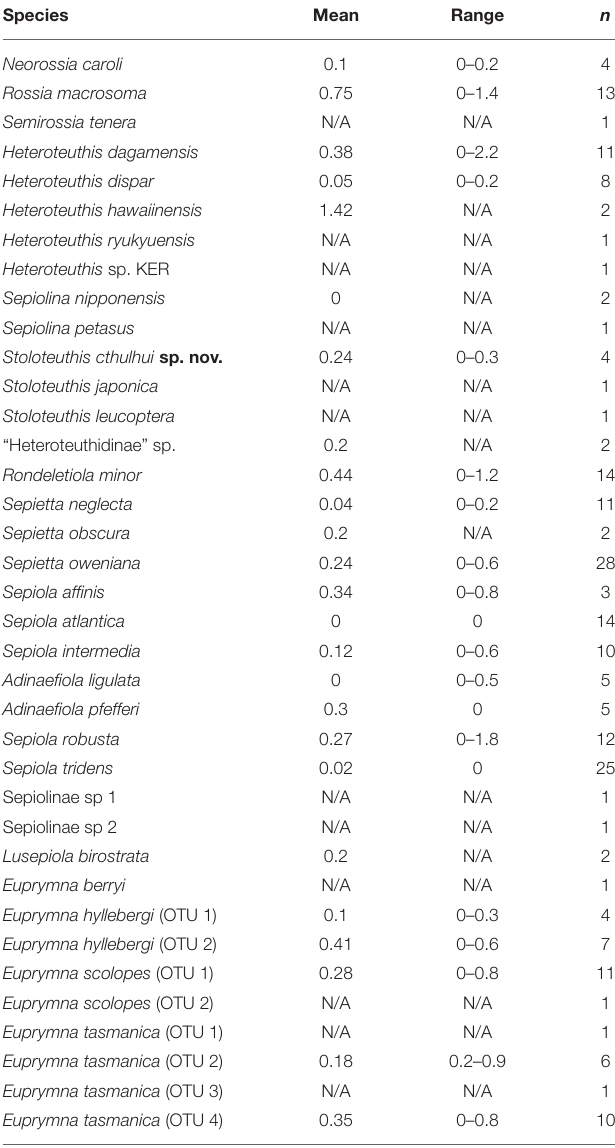
TABLE 3 | Intrapecific p -distance percenteages